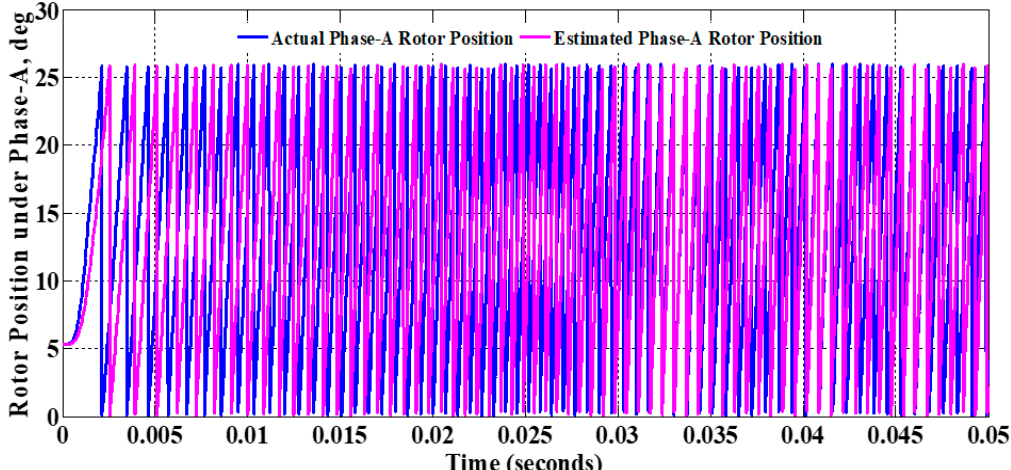
Figure 13. Estimated and actual rotor positions under phase-A.